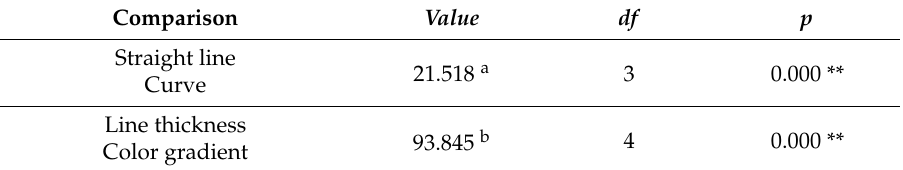
Table 5. Results of Pearson chi-squared test applied to